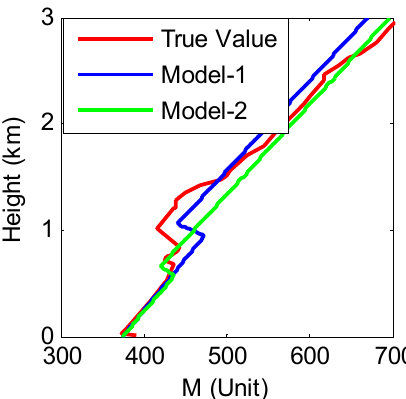
distribution than Model-2 in the range of 80–200 km (the range affected by atmospheric